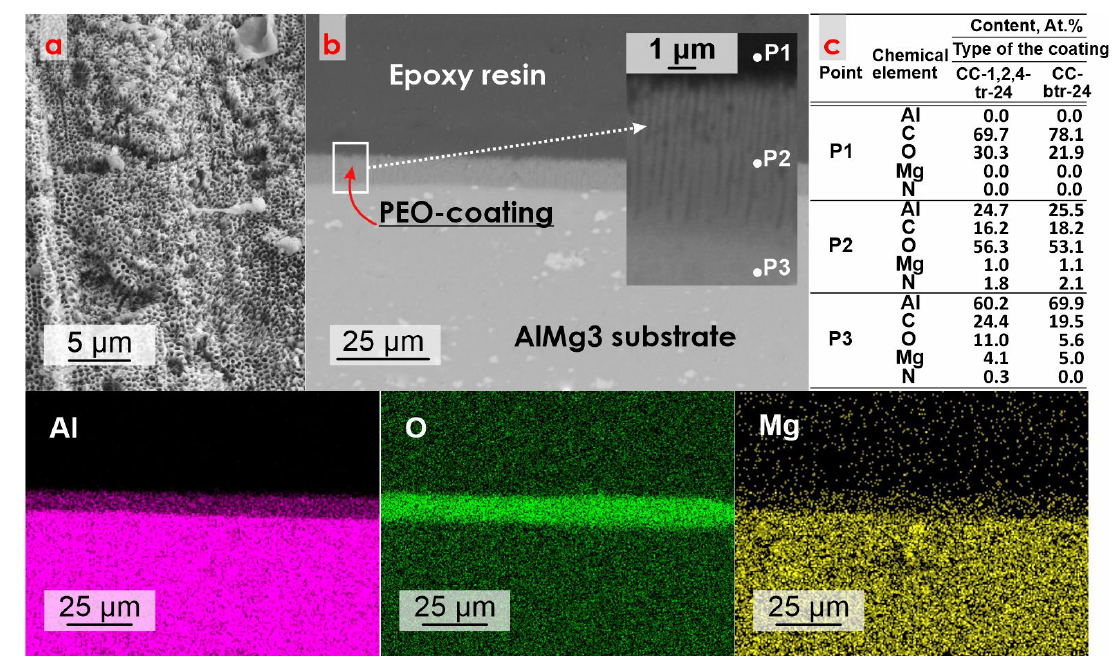
Figure 2. SEM/EDS data of the morphology ( a , b ) and elemental composition of the PEO-coating. EDS data of the element distribution at three points in the cross-section of CC-1,2,4-tr-24 and CC-btr-24 ( c ). The arrow shows the place at composite coating (PEO-layer presented as an example), where EDS spectra were acquired.